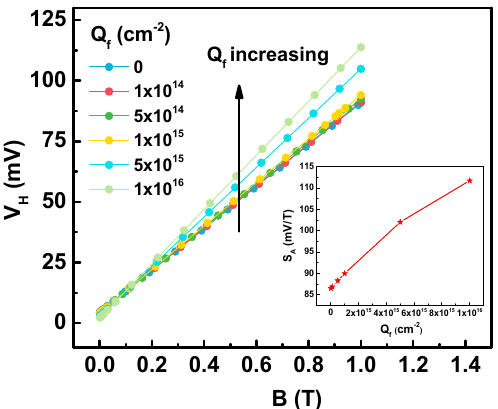
Figure 3. Hall voltage ( V H ) versus magnetic induction ( B ) simulated for sensors with di ff erent fixed charge densities ( Q f ) in the oxide. The inset shows the variation of the absolute sensitivity ( S A ) with fixed charge density.